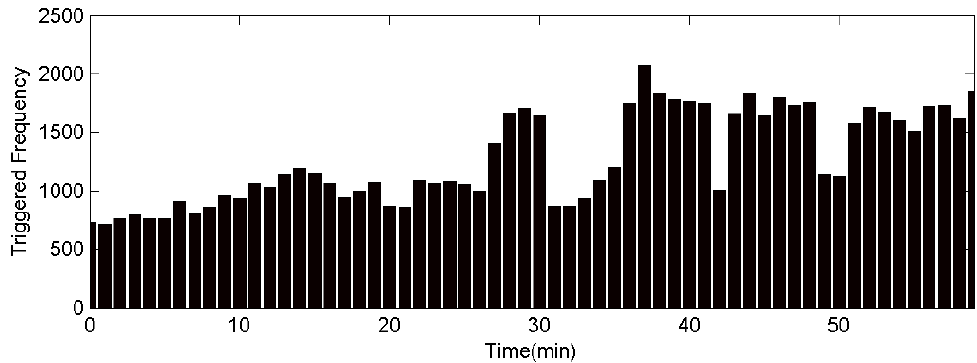
Figure 6. The triggered frequency per minute within an hour of the CCJ station on 17 May 2014.